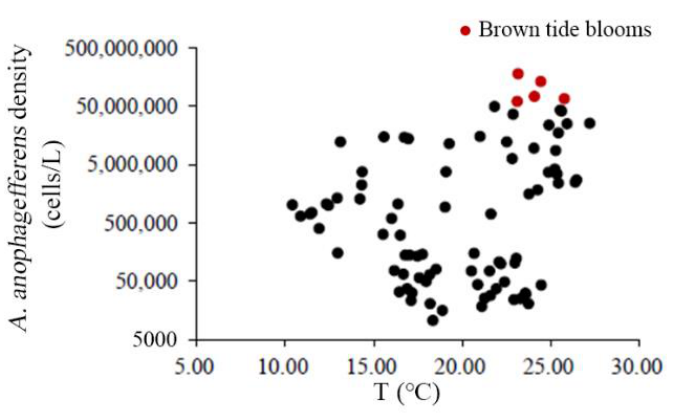
Figure 8. The relationship between T and A. anophagefferens density from June to July in 2013. Based on the correlation between the A. anophagefferens cell density and DON con- centration during the brown tide periods, we tried to explore the correlation between